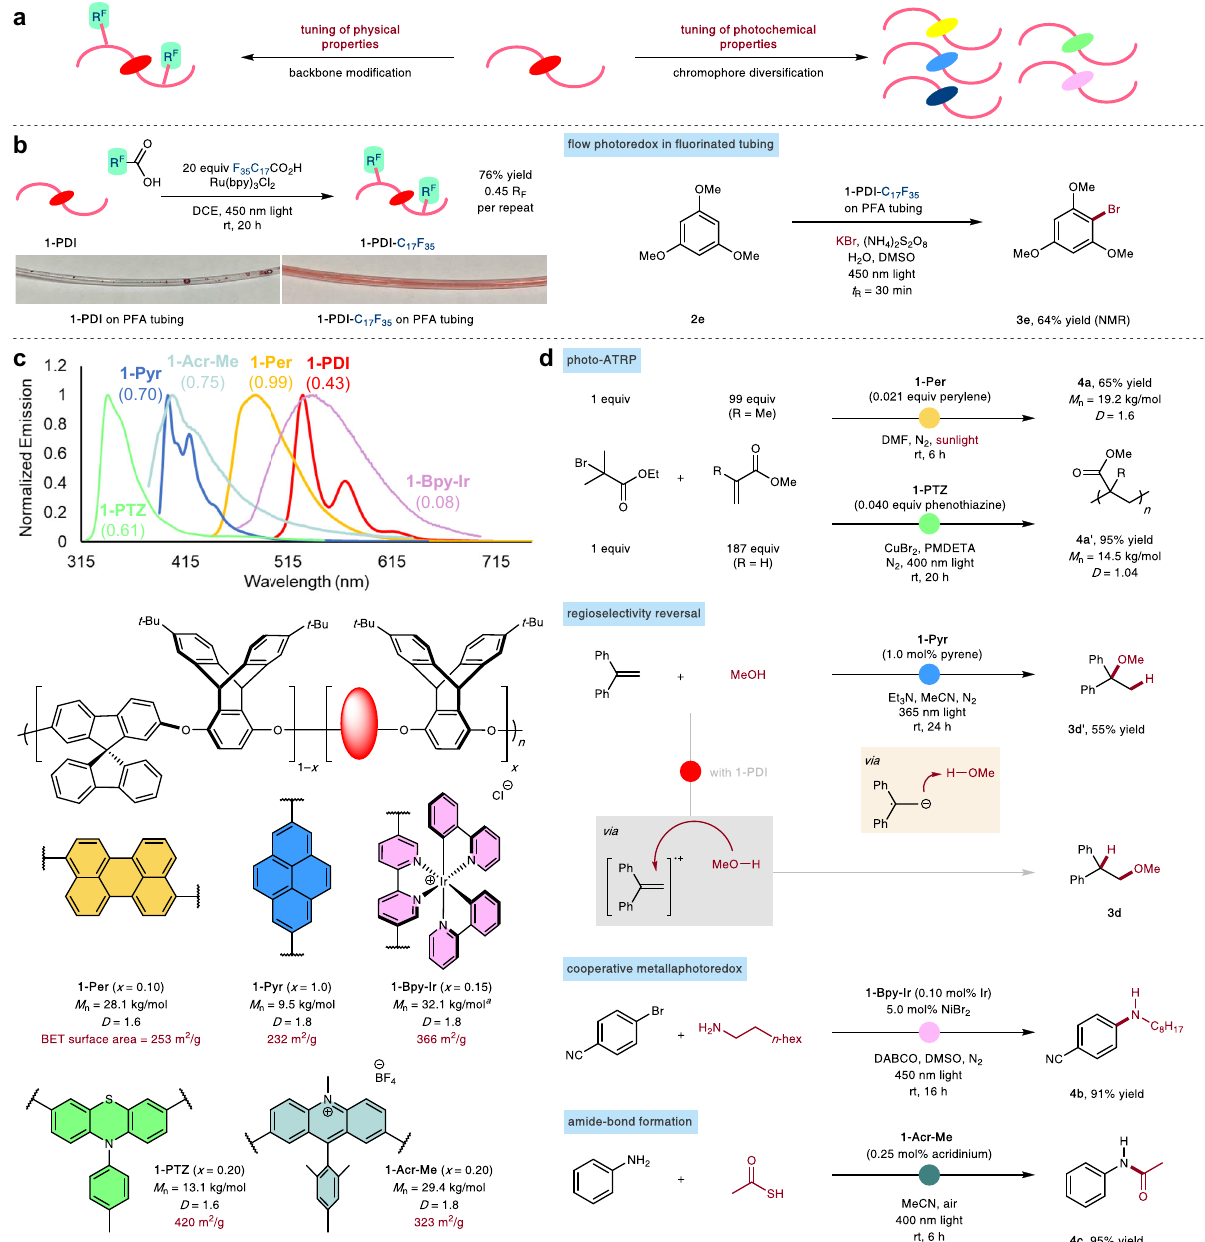
Fig. 4 Tunability of the polymer catalyst. a Convenient and independent alteration of catalyst properties. b Post-polymerization functionalization of the backbone enables adhesion to fl uorinated surfaces for photoredox catalysis. c Structural variation in the photocatalytic moiety: incorporation of common photoredox chromophores. Numbers in parentheses indicate photoluminescence quantum yields in dilute THF solution (1.0 × 10 – 5 – 5.0 × 10 – 7 M). d Example reactions using modi fi ed photocatalysts. a Molecular weight distribution measured on 1-Bpy prior to Ir incorporation. PMDETA